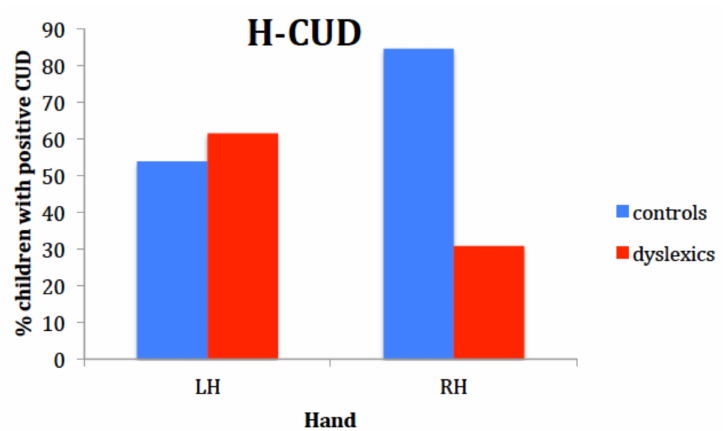
Figure 4. Results of the interhemispheric transfer of visual information task in terms of frequencies within the two children groups of positive CUDs.